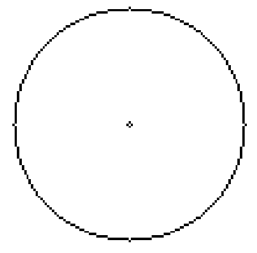
Figure 11. Optimized fitting circle.